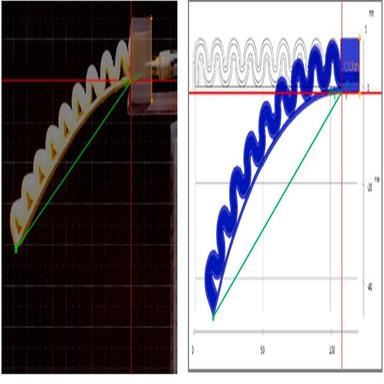
Displacement analysis (5 psi).